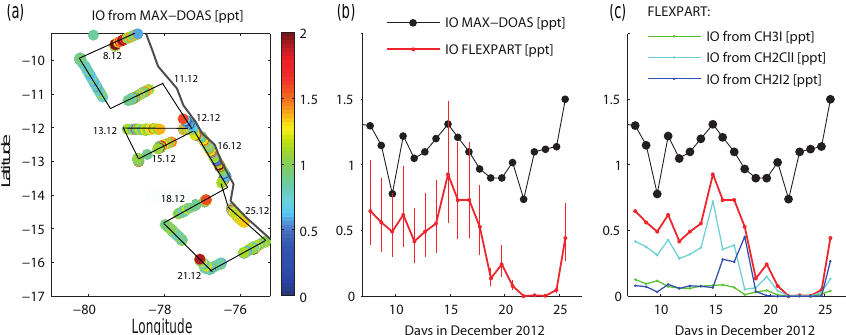
Figure 8. MAX-DOAS measurements of IO during the M91 campaign along the cruise track are shown in panel (a) . Daytime averaged IO values from MAX-DOAS and coincident FLEXPART values are provided in panel (b) . The vertical bars correspond to uncertainties associated with the inorganic iodine lifetime in the MABL (1–3 days) and the daytime fraction of IO to I y (0.15 to 0.3). Contributions of the three oceanic iodocarbon sources to the modelled FLEXPART IO are also given in panel (c)